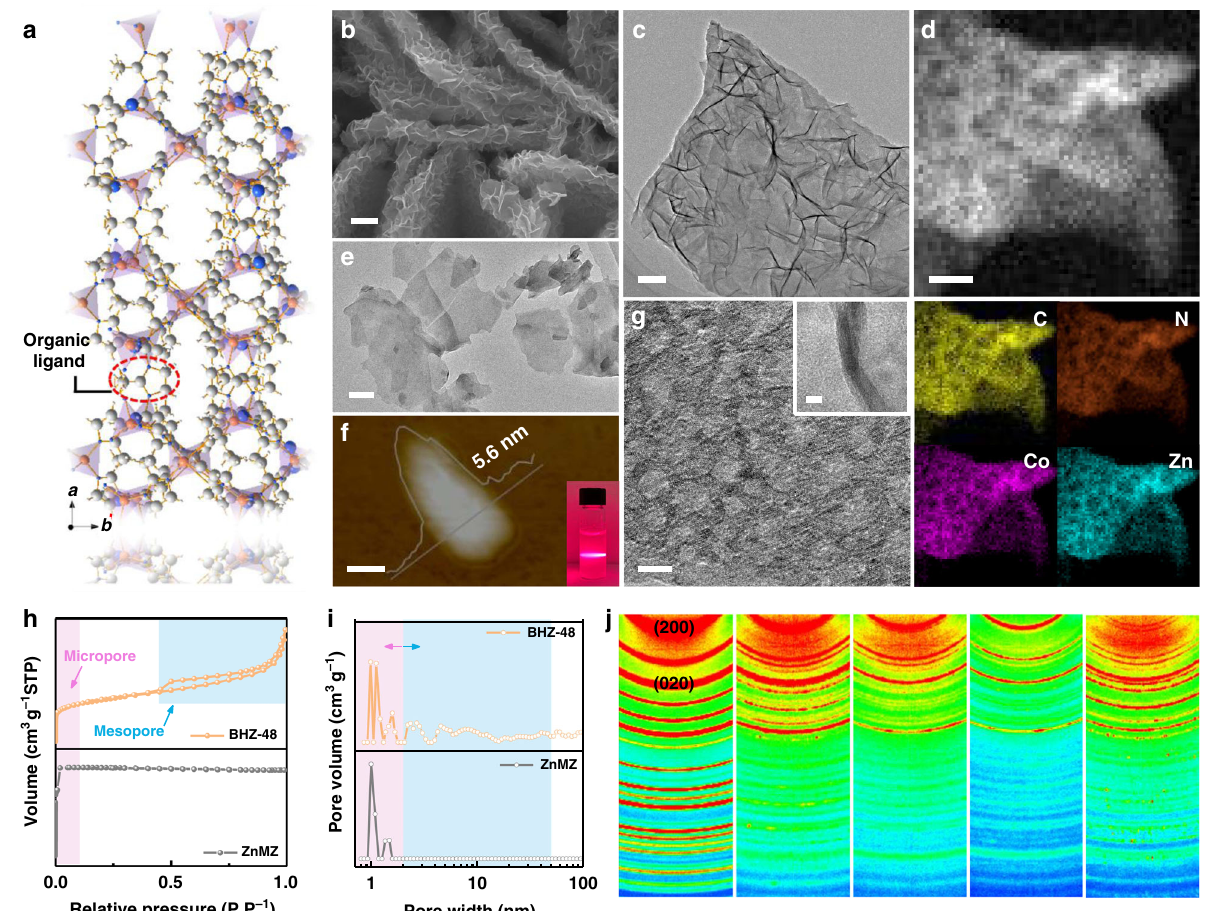
Fig. 1 Morphology and structural properties. a Schematic of the crystal structure of ZnMZ. b SEM and c TEM images of BHZ-48. d Scanning TEM images and corresponding EELS elemental maps of C, N, Co, and Zn atoms. e TEM, f AFM images and corresponding height curves of ultrasonically detached fragment from BHZ-48. Inset: Tyndall light scattering of BHZ-48 nanosheets dispersed in aqueous solution. g High-resolution TEM image of BHZ-48. h N 2 adsorption – desorption isotherms, i pore-size distribution of ZnMZ and BHZ-48. j Two-dimensional WAXS patterns of BHZ-48 and comparison samples, red color represents region with higher diffraction intensity. Scale bars: 1 μ m ( b ), 200 nm ( c ), 10 nm ( d ), 100 nm ( e ), 50 nm ( f ), 5 nm ( g and inset of ( g